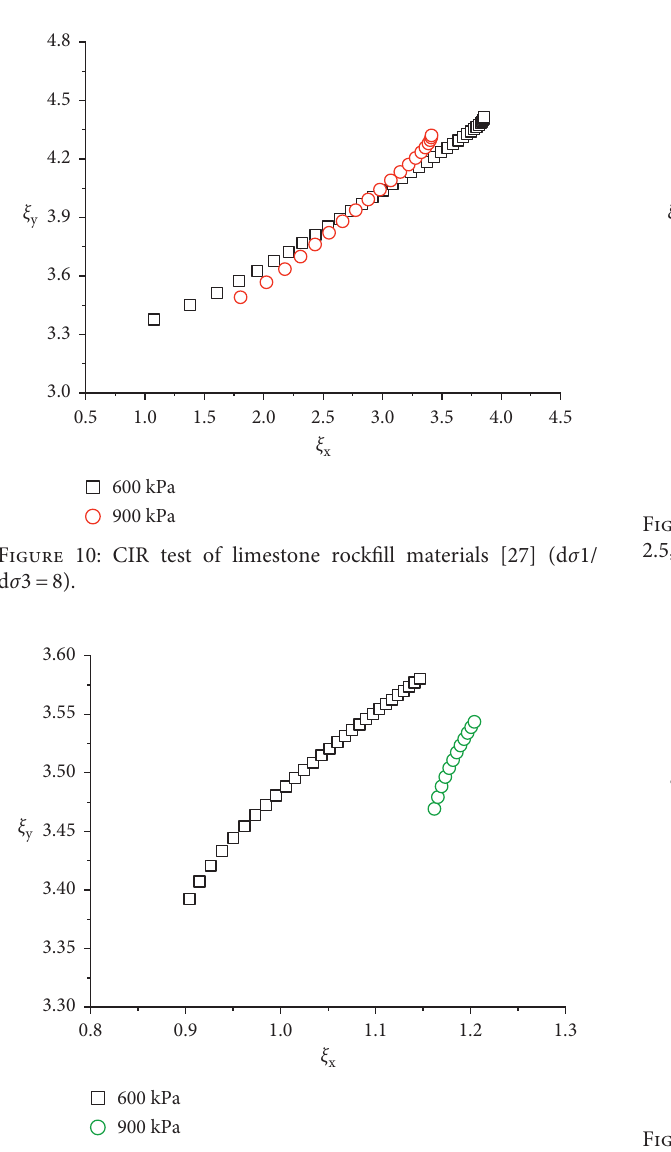
Figure 11: CIR test of limestone rockfill materials [27] (d σ 1/ d σ 3 � 3).